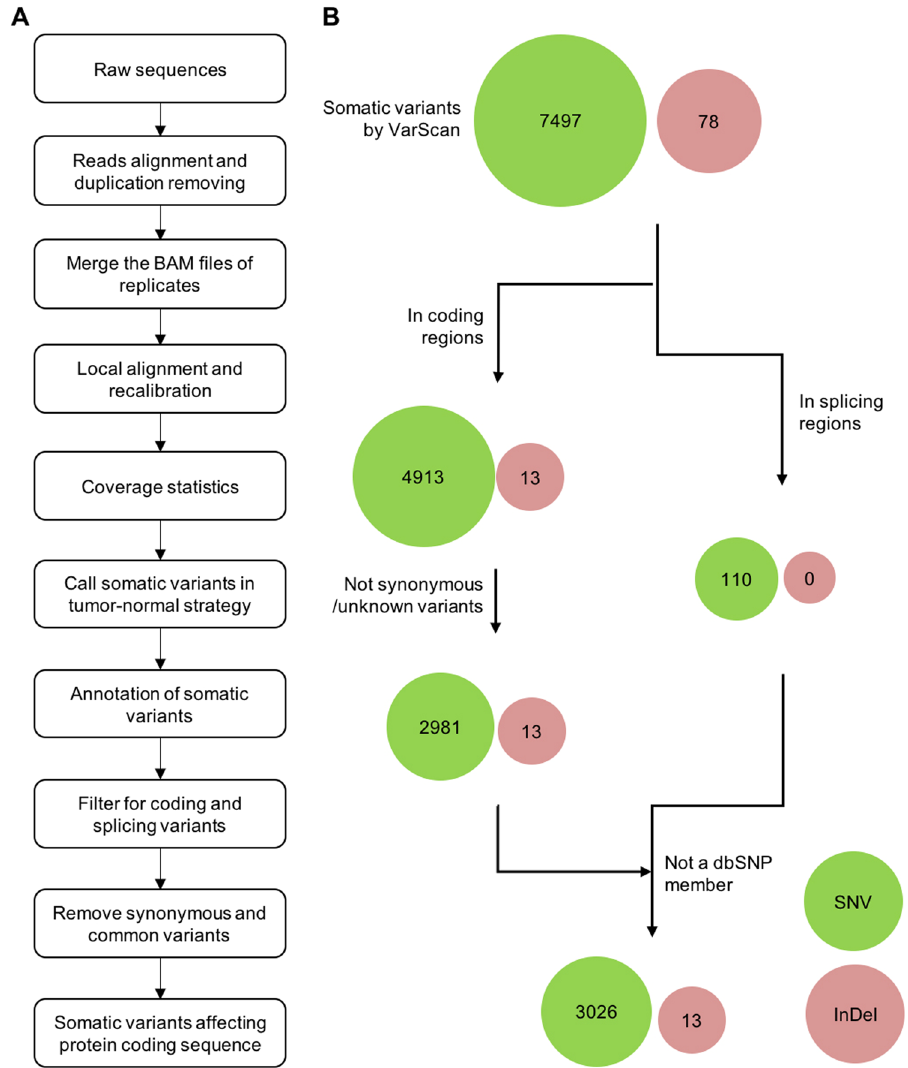
Figure 2. Workflow and filtering strategy for identifying somatic variants affecting protein coding sequence. ( A ) Following the filtration of low-quality reads, all of the qualified reads were aligned to the mouse reference genome with BWA. Duplicated reads were removed and the results of two technical replicates were merged by SAMTools. After the local alignment and recalibration by GATK, the somatic variants of neoplastic samples were called by VarScan2 and further filtered by self-built Perl scripts. ( B ) A cumulative filtration strategy was introduced to identify the somatic variants affecting protein coding sequence. Somatic variants located in coding or splicing regions were achieved according to the annotation results. Those variants annotated as synonymous and unknown by ANNOVAR, as well as those present in dbSNP, were filtered out. With this filtration strategy, 7497 SNVs and 78 InDels were defined as somatic variants in AOM/DSS mouse model, of which 3026 SNVs and 13 InDels were predicted as protein-changing variants. Circles representing SNVs and InDels are colored lawngreen and indianred,